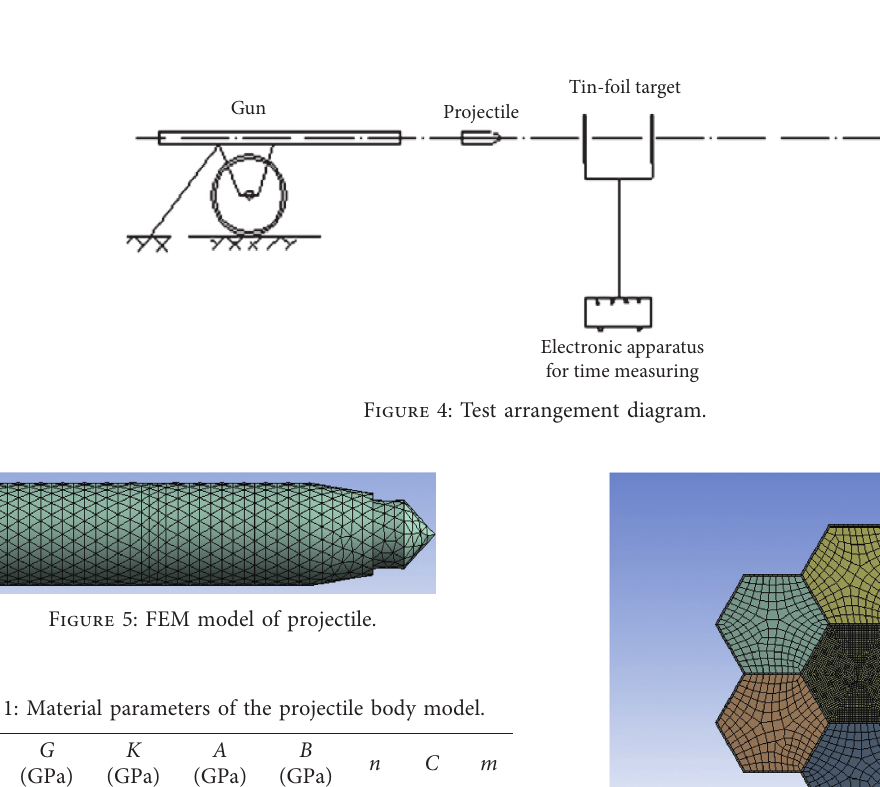
Figure 3: Steel nets in RCT: (a) front view and (b) 1-1 section view.